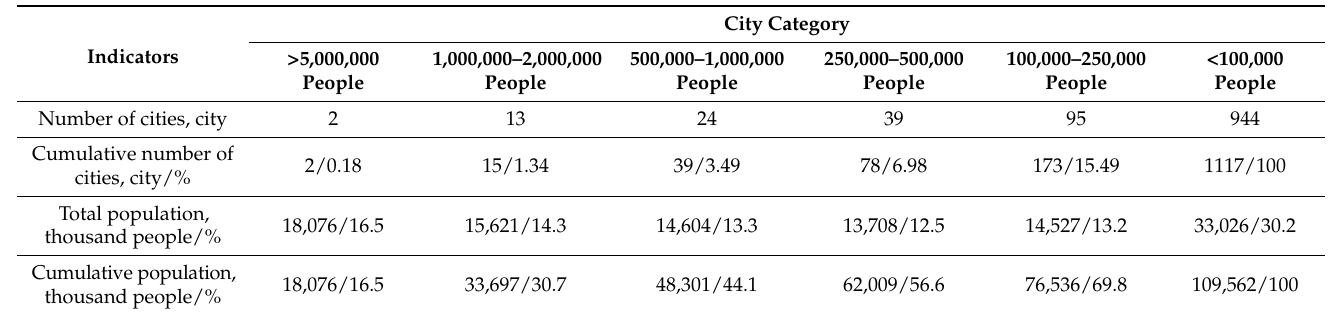
Table 2. Distribution of city population of Russia by city.